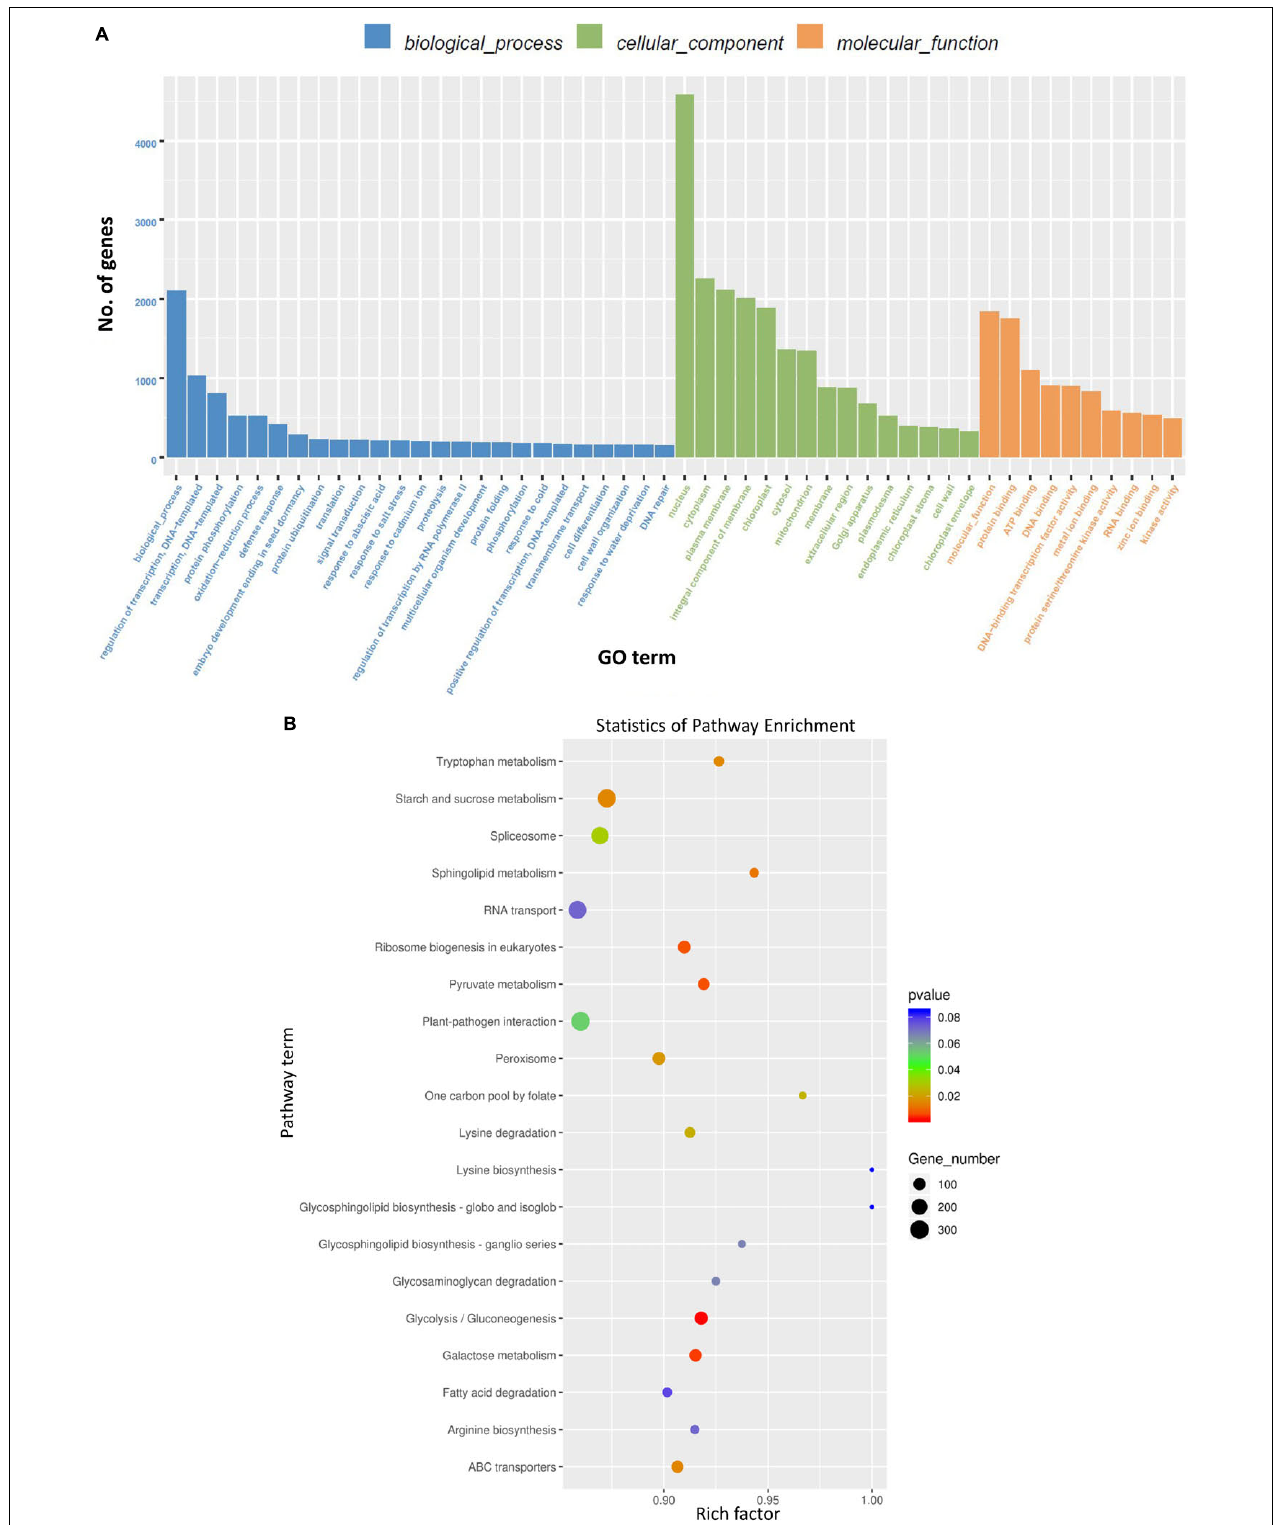
FIGURE 4 | Gene ontology (GO) term and Kyoto Encyclopedia of Genes and Genomes (KEGG) enrichment of the sugar beet gene targets of differentially expressed (DE) sugar beet miRNAs in leaves. (A) GO annotation of sugar beet gene targets of DEmiRNAs in leaves, and (B) KEGG enrichment of sugar beet gene targets of